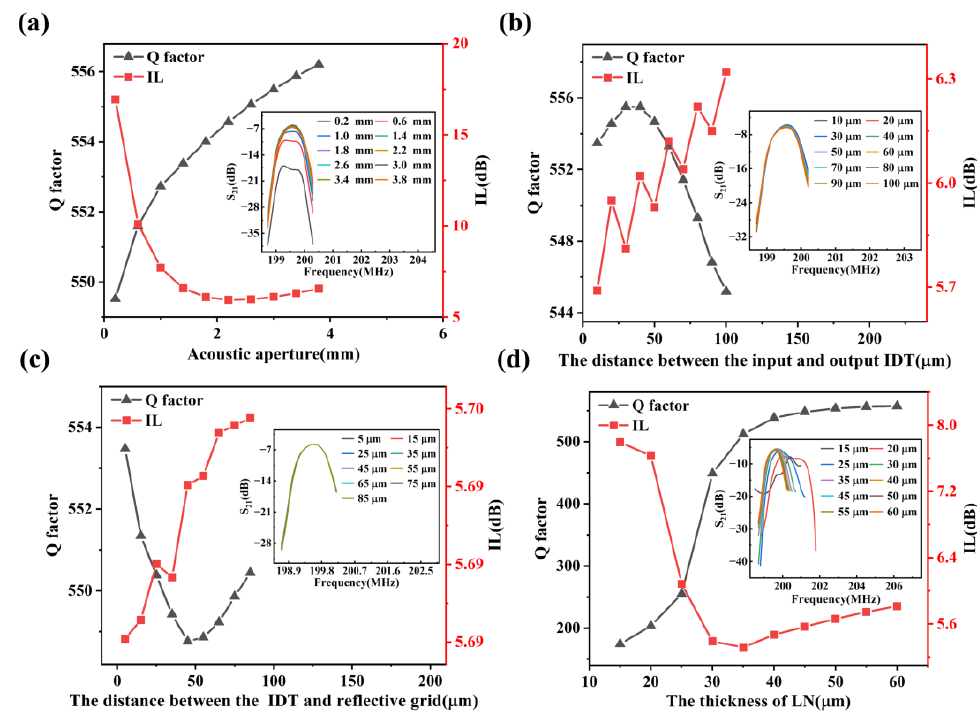
Figure 8. The variation curves of IL and Q of RSAW with respect to the structural parameters of the resonator, where the insets show the resonant peaks of the Rayleigh mode. ( a ) Acoustic aperture. ( b ) The distance between the input and output IDT. ( c ) The distance between the IDT and reflective grid. ( d ) The thickness of LN.